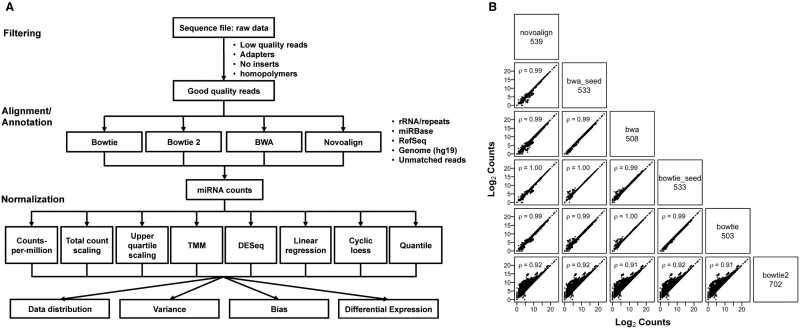
(A) Outline of the experimental design and workflow for evaluating different combinations of alignment tools and normalization procedures. (B) Comparison of alignment tools. miRNA counts recovered from the different aligners were averaged across the samples and plotted for each pairwise comparison. Only miRNAs called present by all the aligners were considered. The aligners being compared are shown on the diagonal, along with the distinct number of miRNAs identified after filtering for species with low counts. Spearman’s correlation coefficients are indicated in the upper left corner for each comparison.